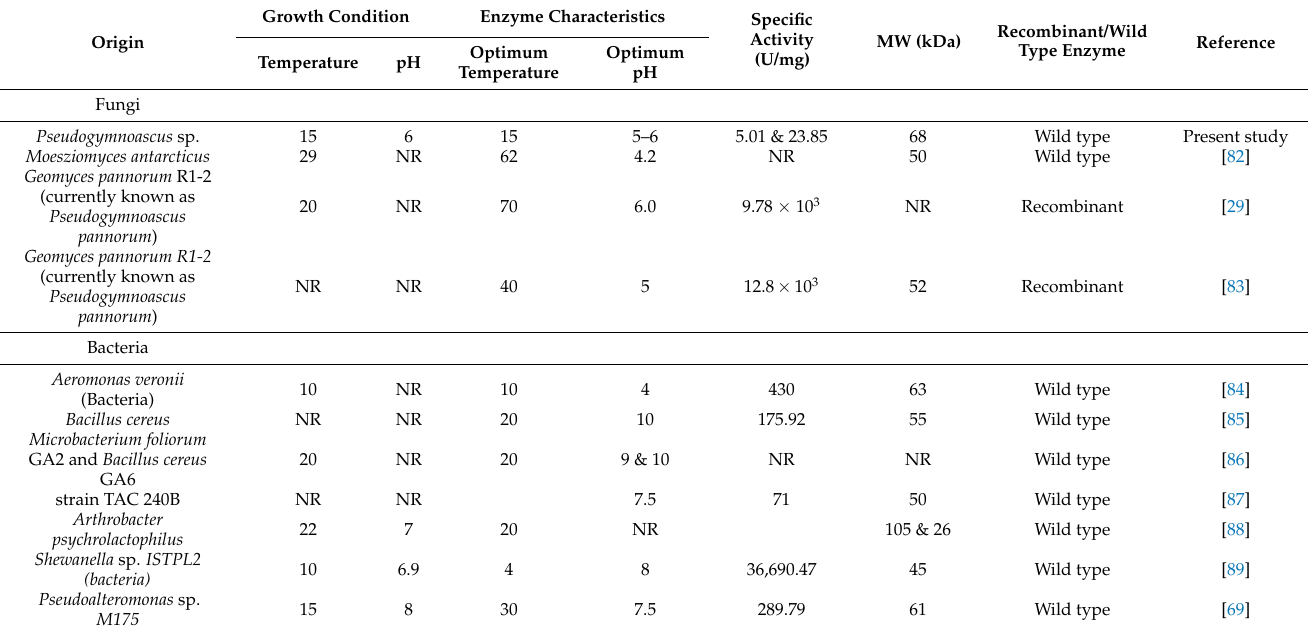
Table 2. Characteristics of psychrophilic α -amylases from fungal and bacterial